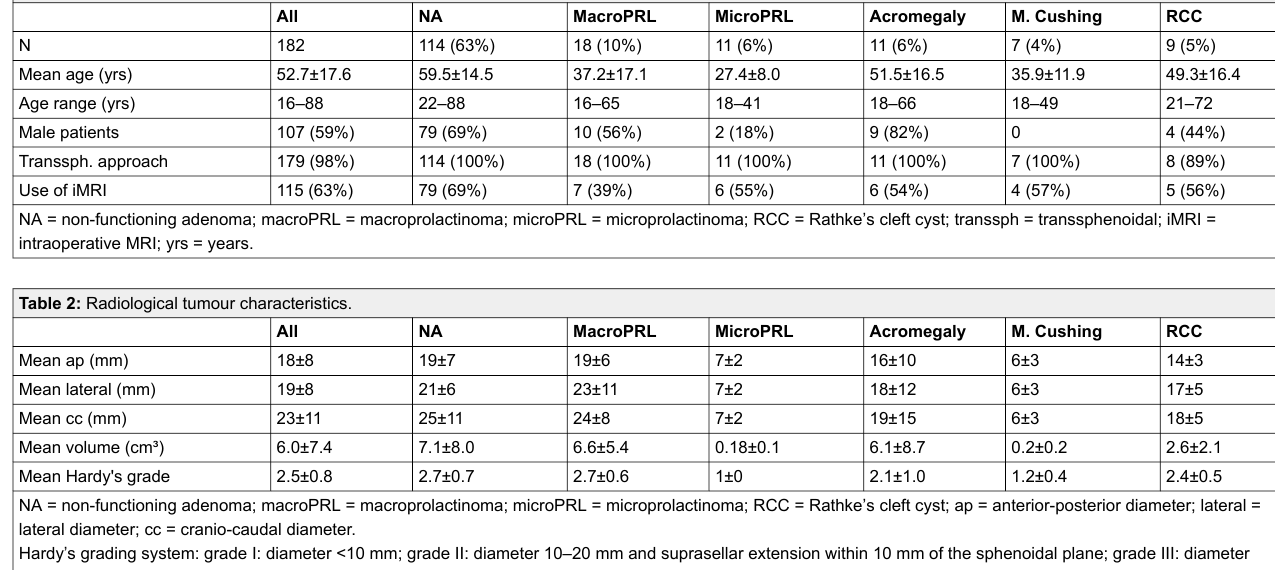
Table 1: Patients’ characteristics.